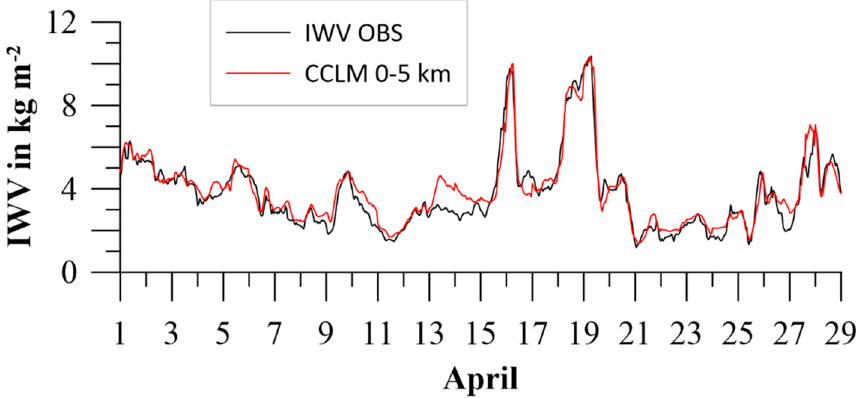
Figure 12. Observations (black) and simulations (red) of the integrated water vapor (IWV) for April 2019.